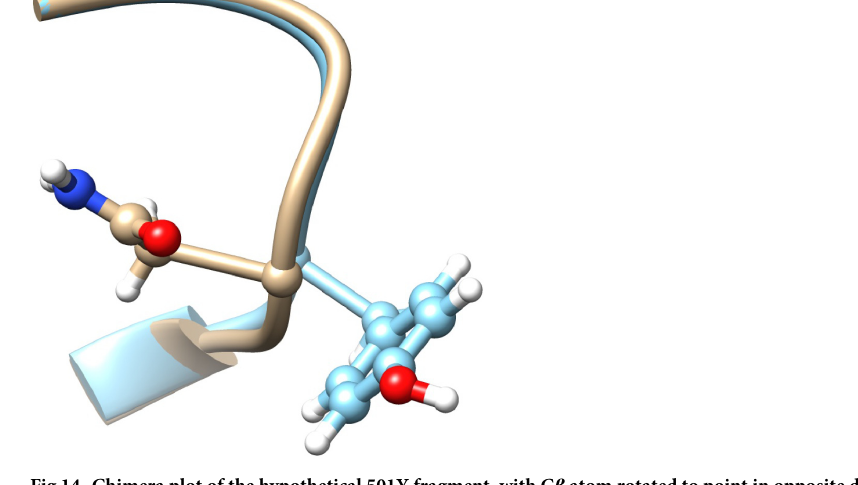
Fig 14. Chimera plot of the hypothetical 501Y fragment, with C β atom rotated to point in opposite direction from that of the C β at 501N. The deformation of the backbone is determined using the methodology described in [43,